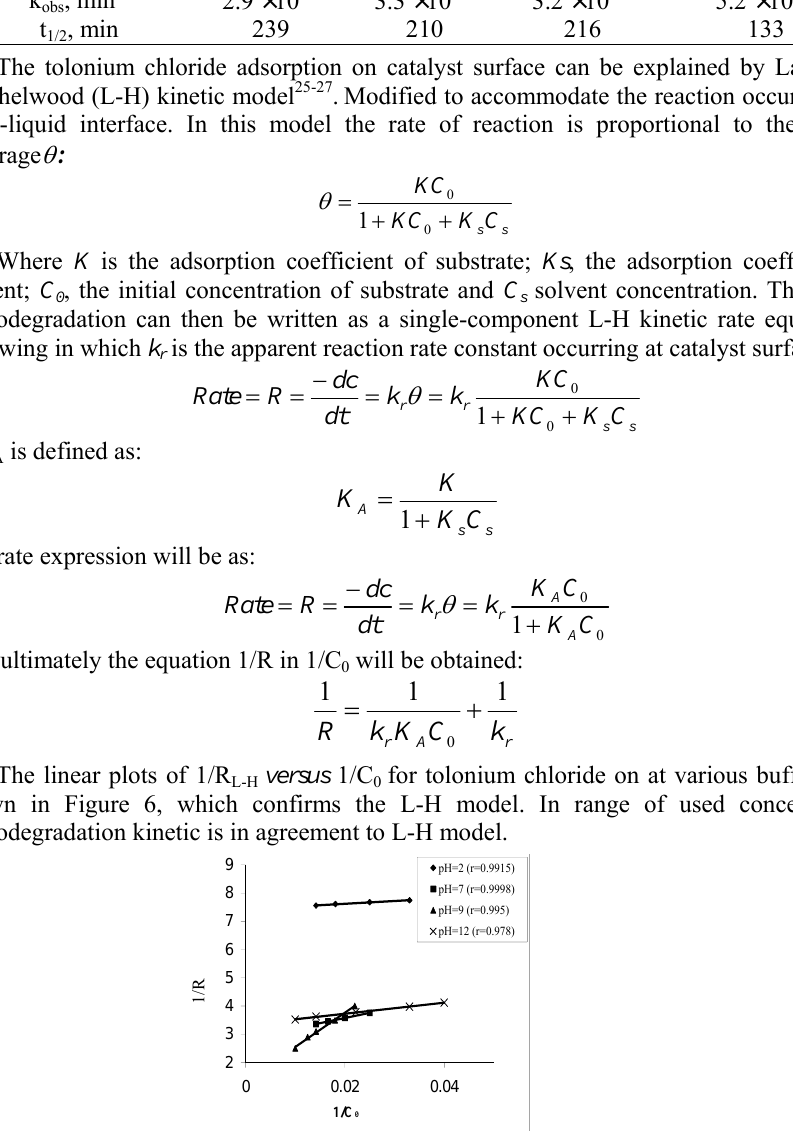
1/C at various buffer pH (Langmuir-Hinshelwood kinetics 0